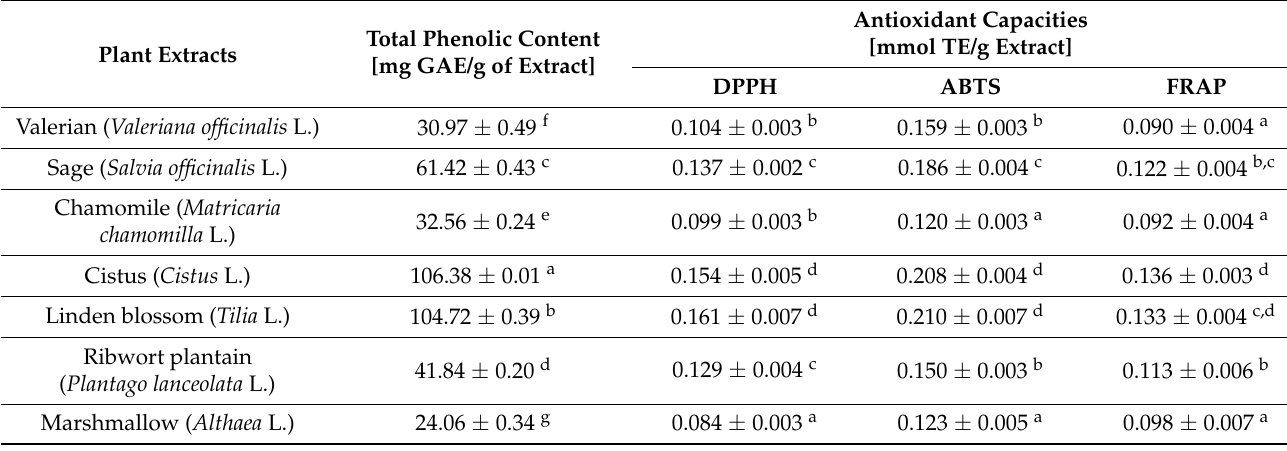
Table 2. The TPC and Trolox equivalent antioxidant capacity of plant extracts determined by DPPH, ABTS, and FRAP assays (average values and standard deviations of three